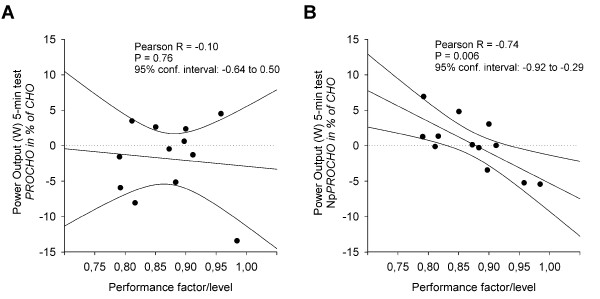
Correlation between performance level measured as a performance factor calculated from Wmax, VO2max and familiarization test 5-min mean-power cycling performance (see Table 2 for thorough description) and performance in 5-min mean-power test following 120 min submaximal cycling at 50% of Wmax with ingestion of either A) protein + carbohydrate (PROCHO) or B) Nutripeptin™ + protein + carbohydrate (NpPROCHO). Power-output values for the two beverages were referenced to values obtained for the carbohydrate (CHO) beverage, which was defined as baseline performance. Values on the Y-axis thus depicts the difference in performance between PROCHO and CHO ingestion and NpPROCHO and CHO ingestion, respectively, and is denoted as percentage.